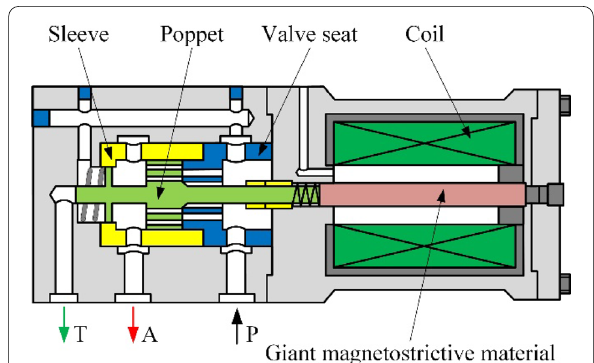
Figure 19 Poppet valve with a giant magnetostrictive actuator provided by Ma